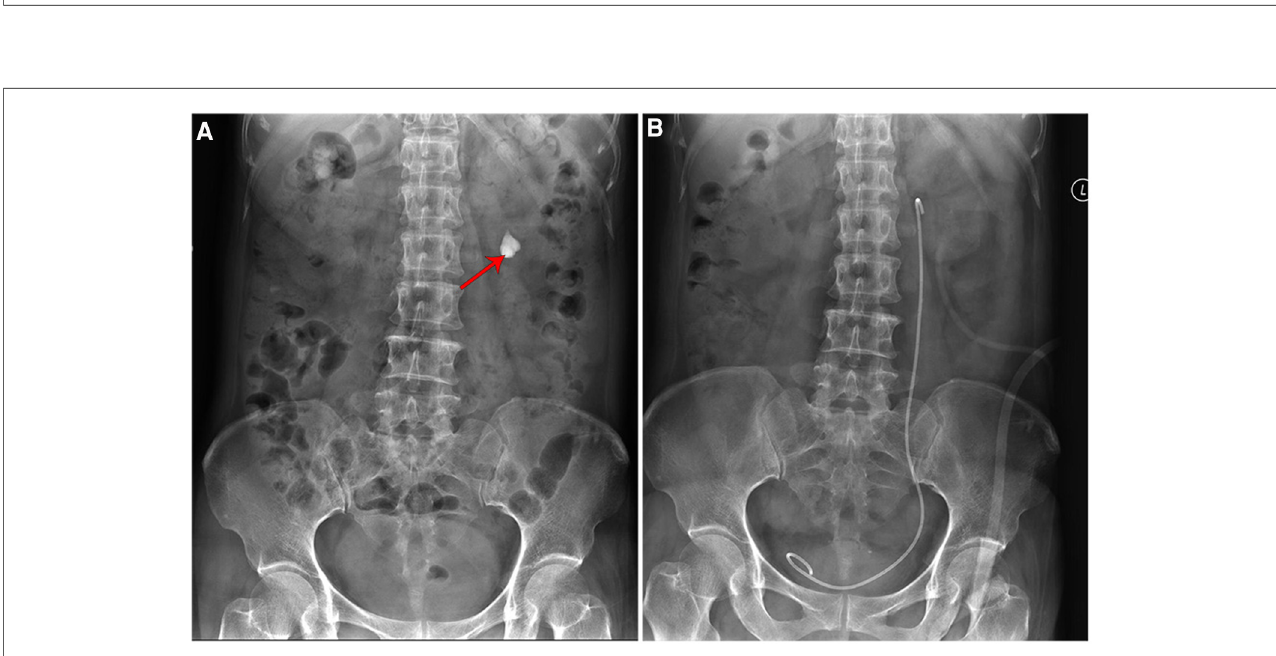
FIGURE 6 Kidney-ureter-bladder (KUB) showed ( A ) a stone in the left lower renal calyx (red arrow, 20 mm×17 mm). ( B ) Renal calyx was removed after percutaneous